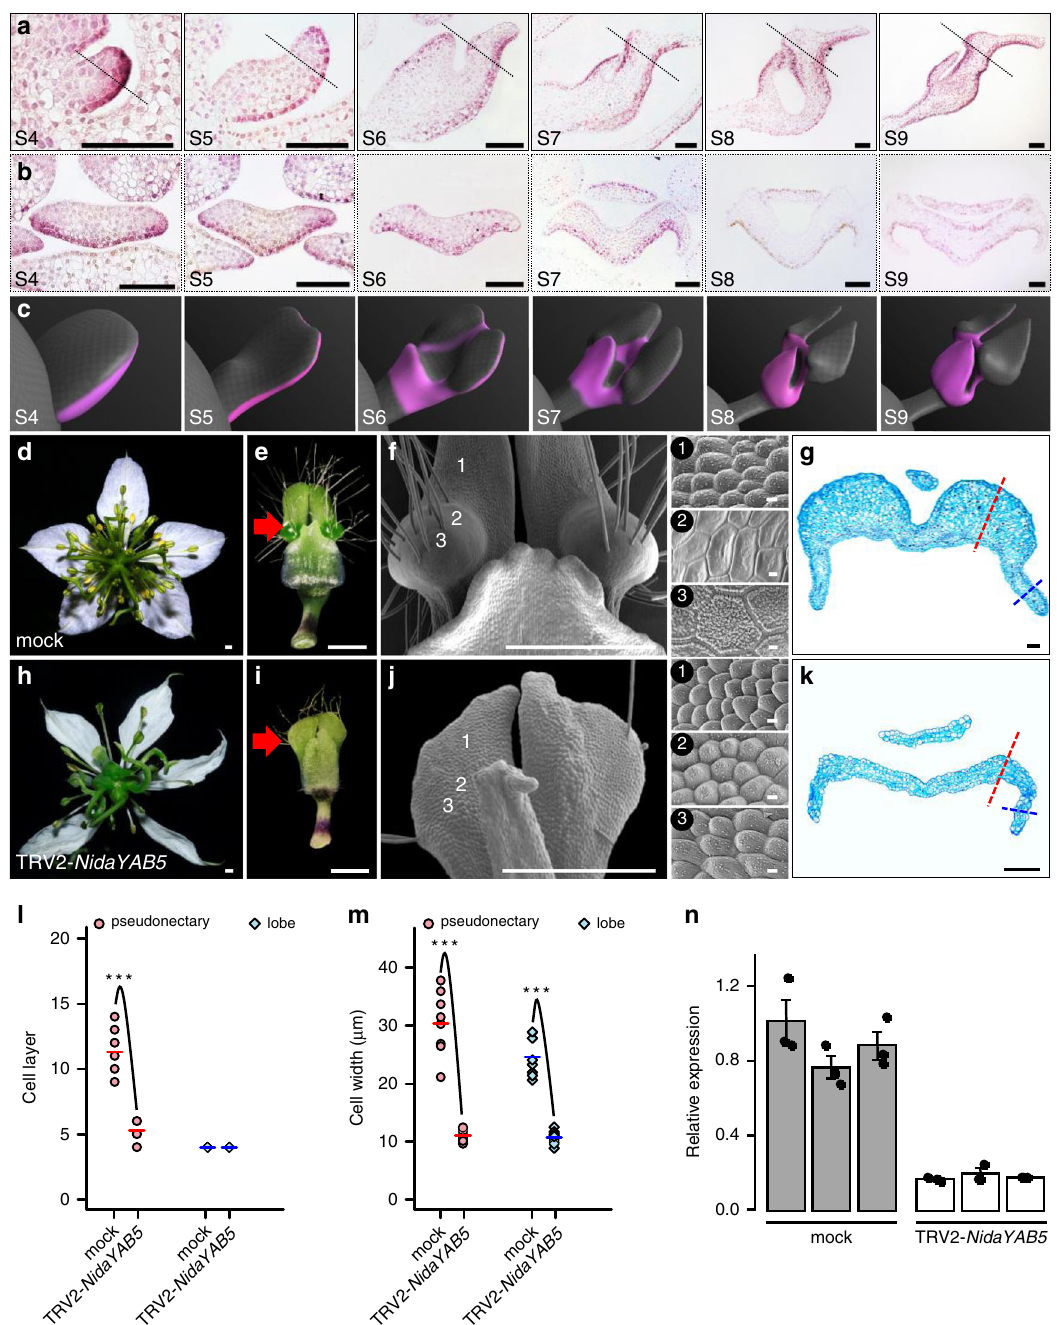
Fig. 5 Expression and function of NidaYAB5 . a , b The results of in situ hybridization of NidaYAB5 in petals. Dashed lines in the longitudinal sections ( a ) indicate the positions at which the transverse sections ( b ) were made. Scale bars: 100 μ m. For a , b , the experiments were repeated three times independently with similar results. c Virtual clay models showing the expression domains (pink) of NidaYAB5 in petals. Phenotypes of the mock ( d – g ) and TRV2- NidaYAB5 -treated fl owers with strong phenotypic changes ( h – k ). The fl owers and mature petals are shown in d , h and e , i , respectively. The micromorphology and anatomy of the pseudonectary regions are shown in f , j and g , k , respectively. 1 – 3 next to f and j indicate the corresponding regions on the surface of the mock and TRV2- NidaYAB5 -treated petals. Red arrows point to the pseudonectary region, and dashed lines indicate the pseudonectary (red) and lobe (blue) areas at which the cell layer ( l ) and cell width ( m ) were recorded. Scale bars: d – f , h – j , 1 mm; 1 – 3, 10 μ m; g , k , 100 μ m. Comparisons of cell layer ( l ) and cell width ( m ) at the pseudonectary and lobe areas between mock and TRV2- NidaYAB5 -treated fl owers. Bars indicate the mean values. The asterisks indicate the signi fi cant difference by two-side Wilcoxon rank sum test ( P value < 0.001) between samples. The exact P values were listed in the Source Data. Source data for l and m are provided as a Source Data fi le. n The results of qRT-PCR for NidaYAB5 in petals of mock and TRV2- NidaYAB5 - treated fl owers. Each treatment includes three biological replicates. Error bars indicate the standard deviation (SD) of three technical replicates of each biological replicate. The measure of the center for the error bars is the mean value of three technical replicates of each biological replicate. Data are presented as mean values ±